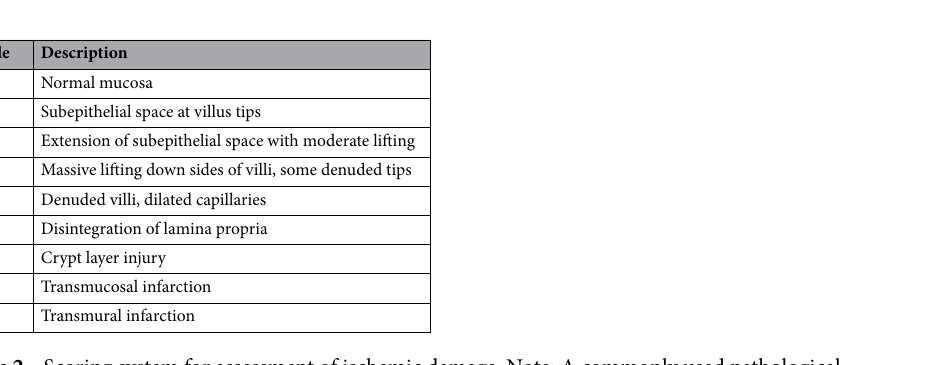
Table 2. Scoring system for assessment of ischemic damage. Note: A commonly used pathological classification system for ischemic mucosal lesions proposed by Chiu et al. 37 , including modifications proposed by Park et al. 38 .